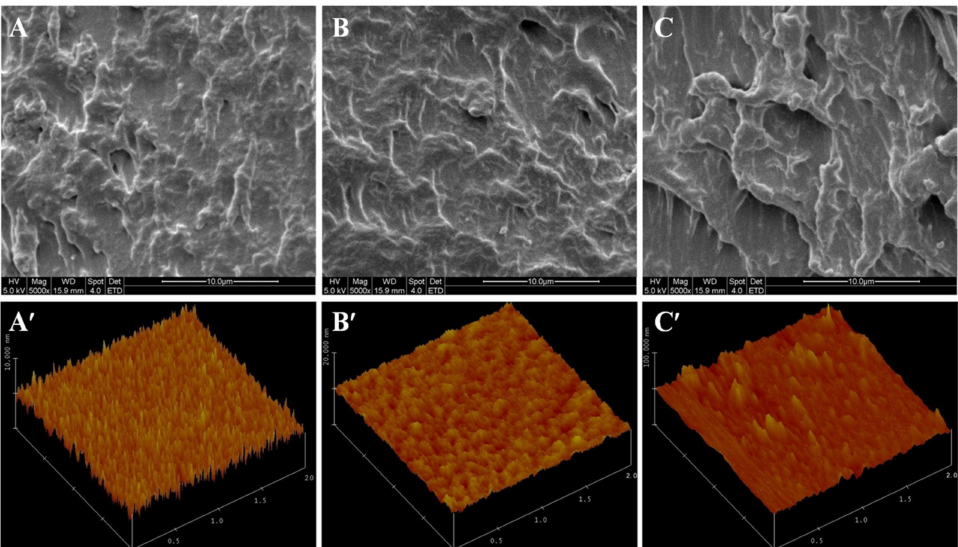
Figure 2. Cross-section SEM images (upper panel) and AFM surface images (lower panel) of control ( A , A (cid:48) ), 2.5% oxidized ferulic (OFA; B , B (cid:48) ) and tannic (OTA; C , C (cid:48) ) acid-treated WPI films.